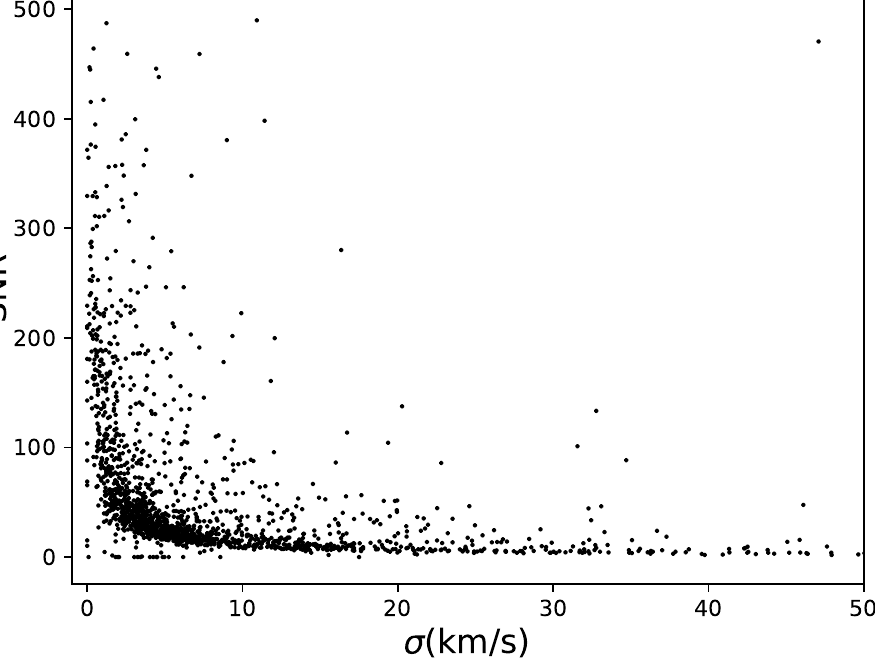
Figure 4. The SNR of spectra vs. the RV uncertainties of the